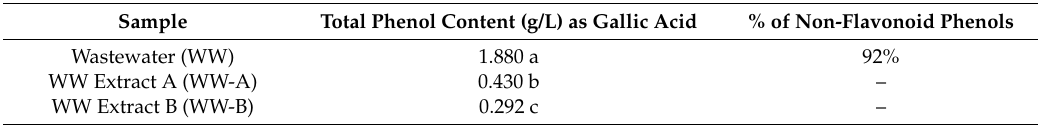
Table 2. Total phenol content of wastewater and wastewater extracts.